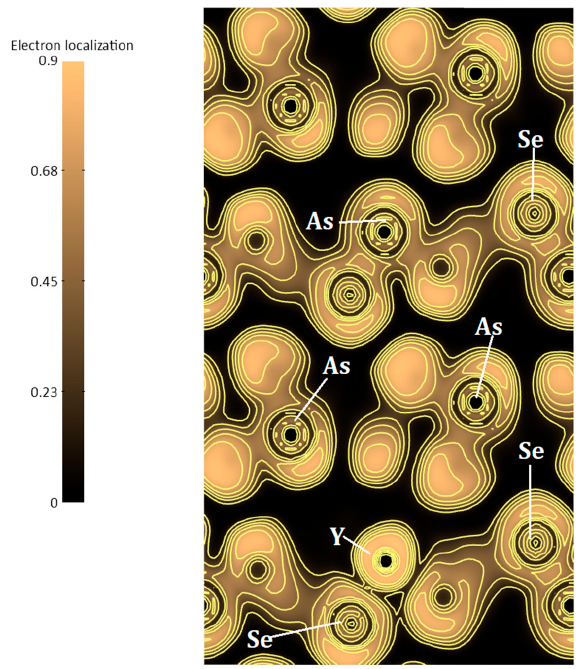
Figure 9. Electron-localization function (e / Å 3 ) in (100) plane of Y addition in As 2 Se 3.